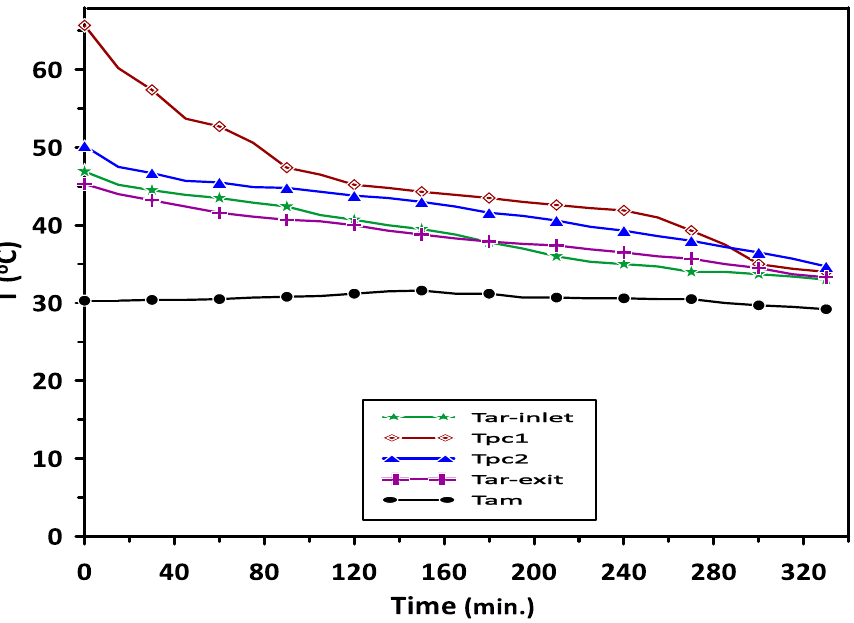
Figure 8. Variations in PCMs and room model air temperatures with the time during the discharging cycle at ambient temperature of 30 °C.